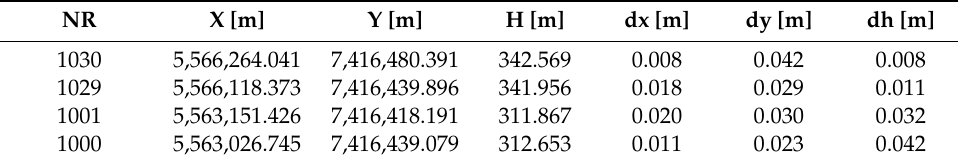
Table 1. Results of the static Global Navigation Satellite System (GNSS) survey. Coordinates in PL-2000 (zone 7) (EPSG code: 2177).